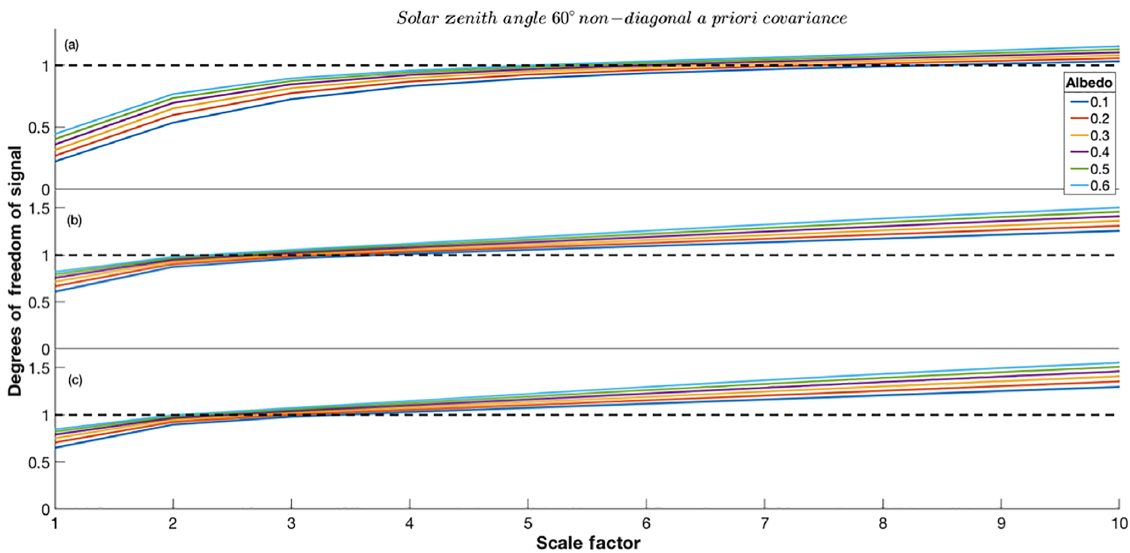
Figure A2. Degrees of freedom for 13 CH 4 vs. scaling factor f for scenarios outlined in Table 3. Each coloured line represents different surface albedo conditions as shown in the key. The black dashed line represents unity DOFS: panel (a) indicates scenario 3, panel (b) indicates scenario 6 and panel (c) indicates scenario